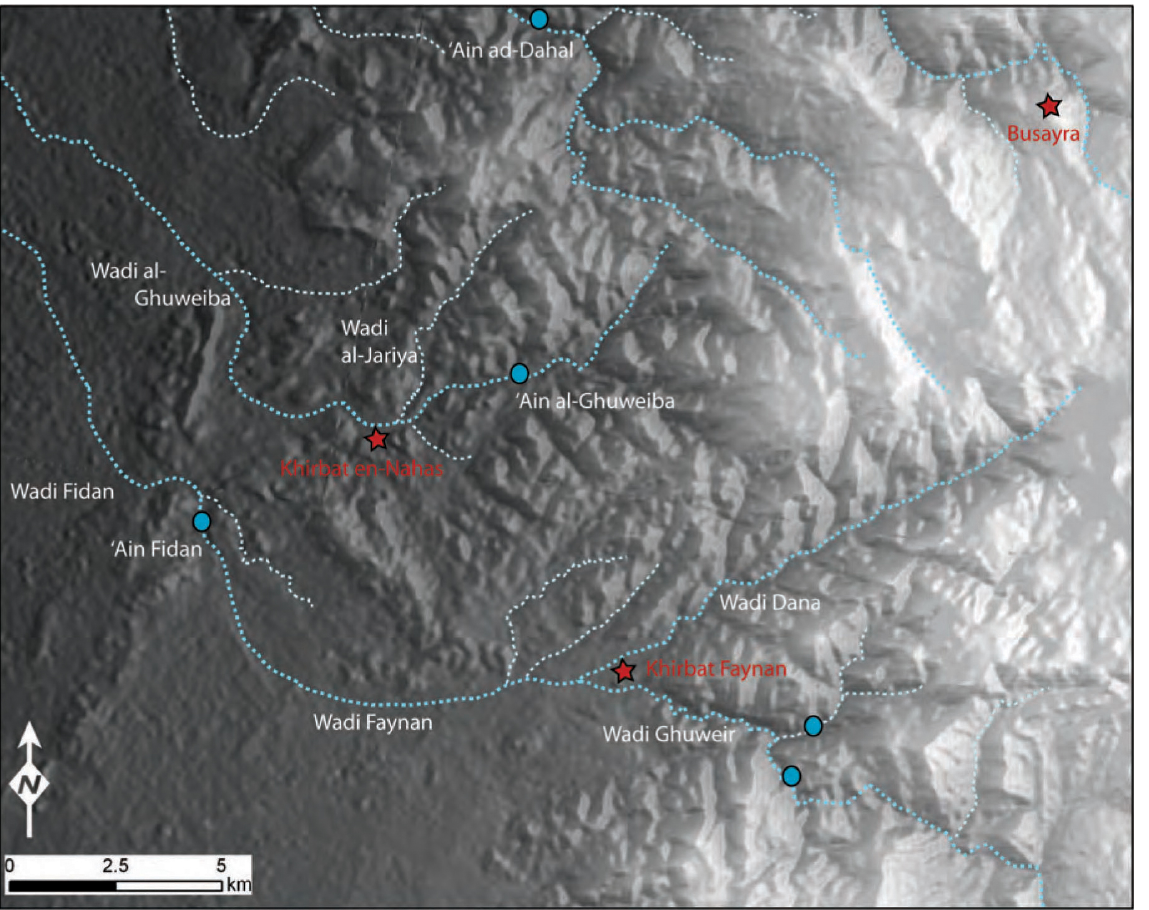
Figure 3. Map of the major drainage basins and springs (indicated by solid circles) in the area of Faynan, Jordan. The three most notable Iron Age archaeological sites are indicated by stars. (Based on Levy et al.